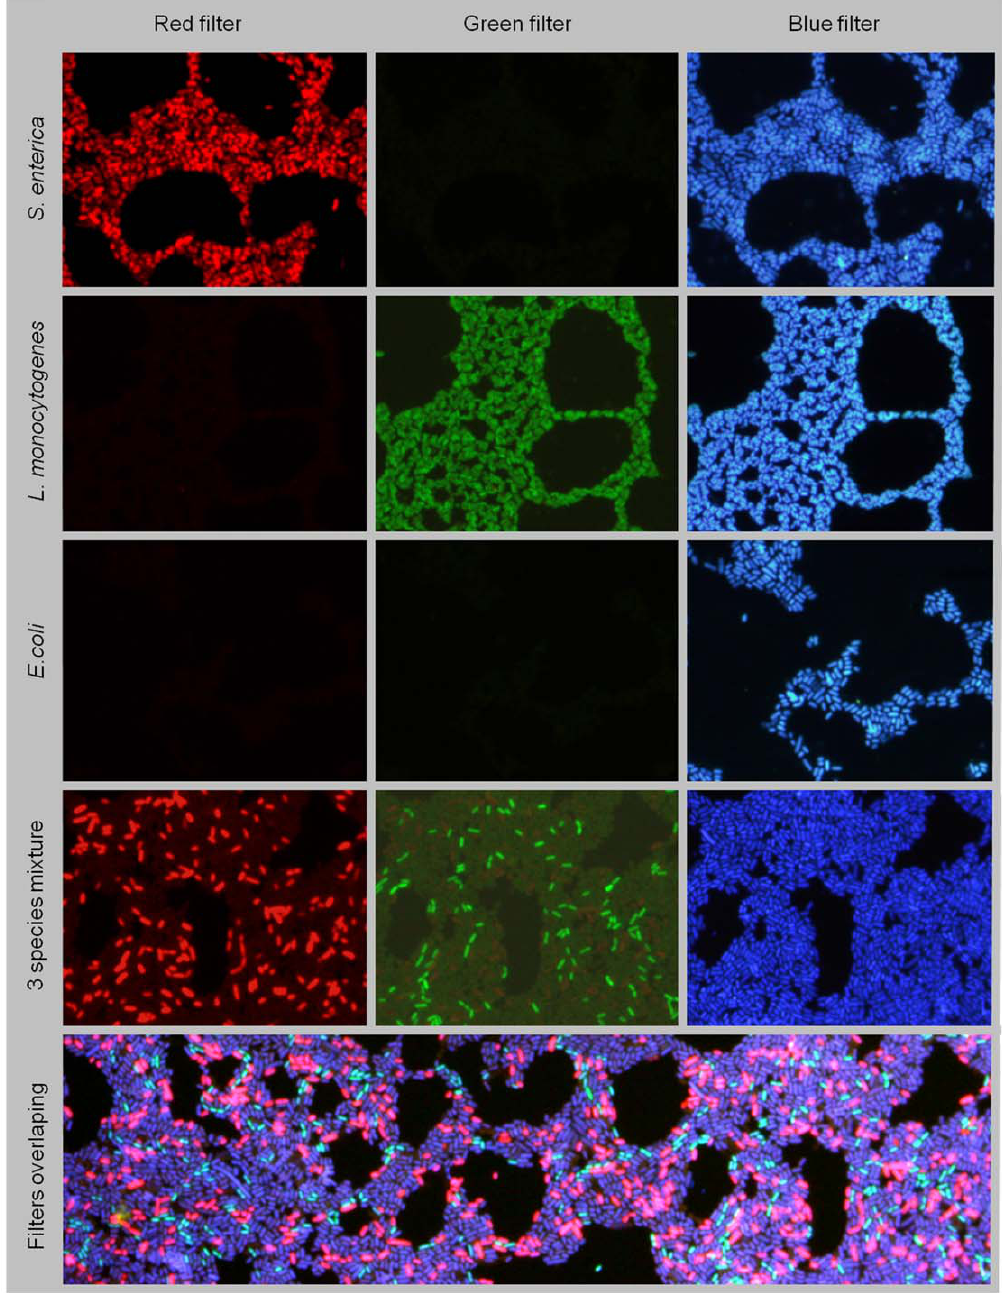
Figure 1. Epifluorescence microscopy pictures of a multiplex assay for mono-species and a three-species smear, using two PNA probes (SalPNA1873 and LmPNA1253) and DAPI staining. In the columns we have the microscopy filter used to visualize each fluorochrome (from left to right, Alexa 594, Alexa 488 and DAPI). The first three rows present the pure smears for each species used. No cross-hybridization was observed between the two PNA probes. The fourth row shows a smear with the three species mixed. The bottom image represents the bands superposition discriminating the cells of the three populations.